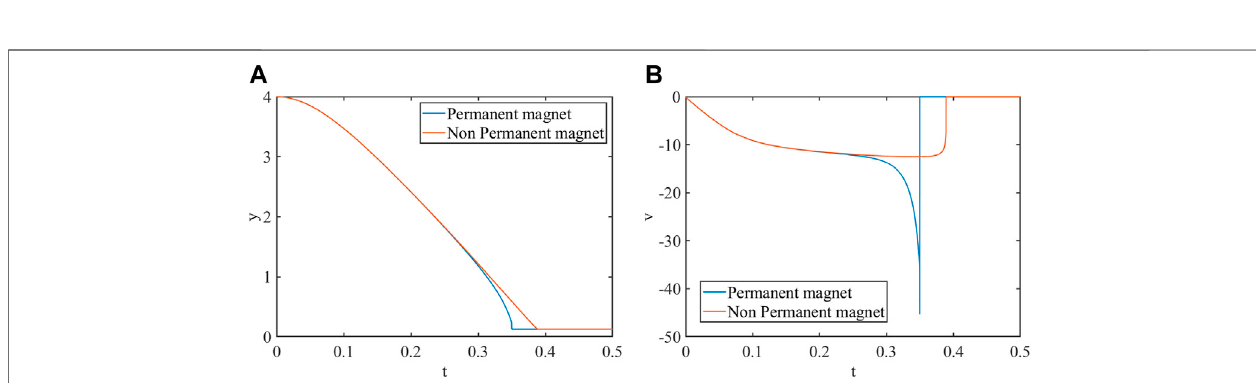
FIGURE 11 | The magnetic stress f m in x -direction (A) and in y -direction (B) on the particle interface at t (cid:2) 0 . 4 s , 0 . 5 s , 0 . 6 s .